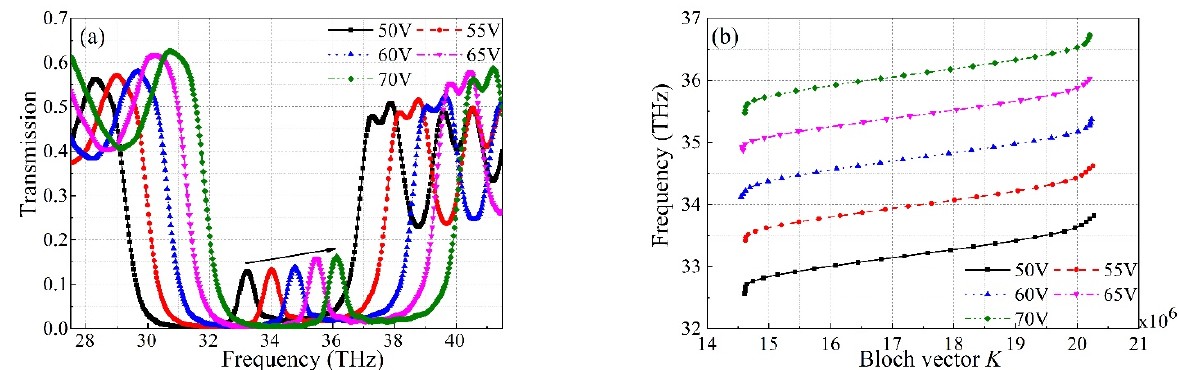
Figure 5. ( a ) Transmission spectra and ( b ) dispersion relationships of the graphene waveguide with different bias voltages.